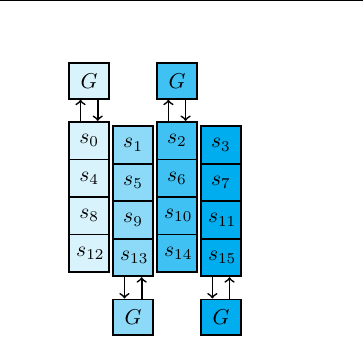
Figure 2: Function G applies on state Figure 3: Function G applies on state diag-